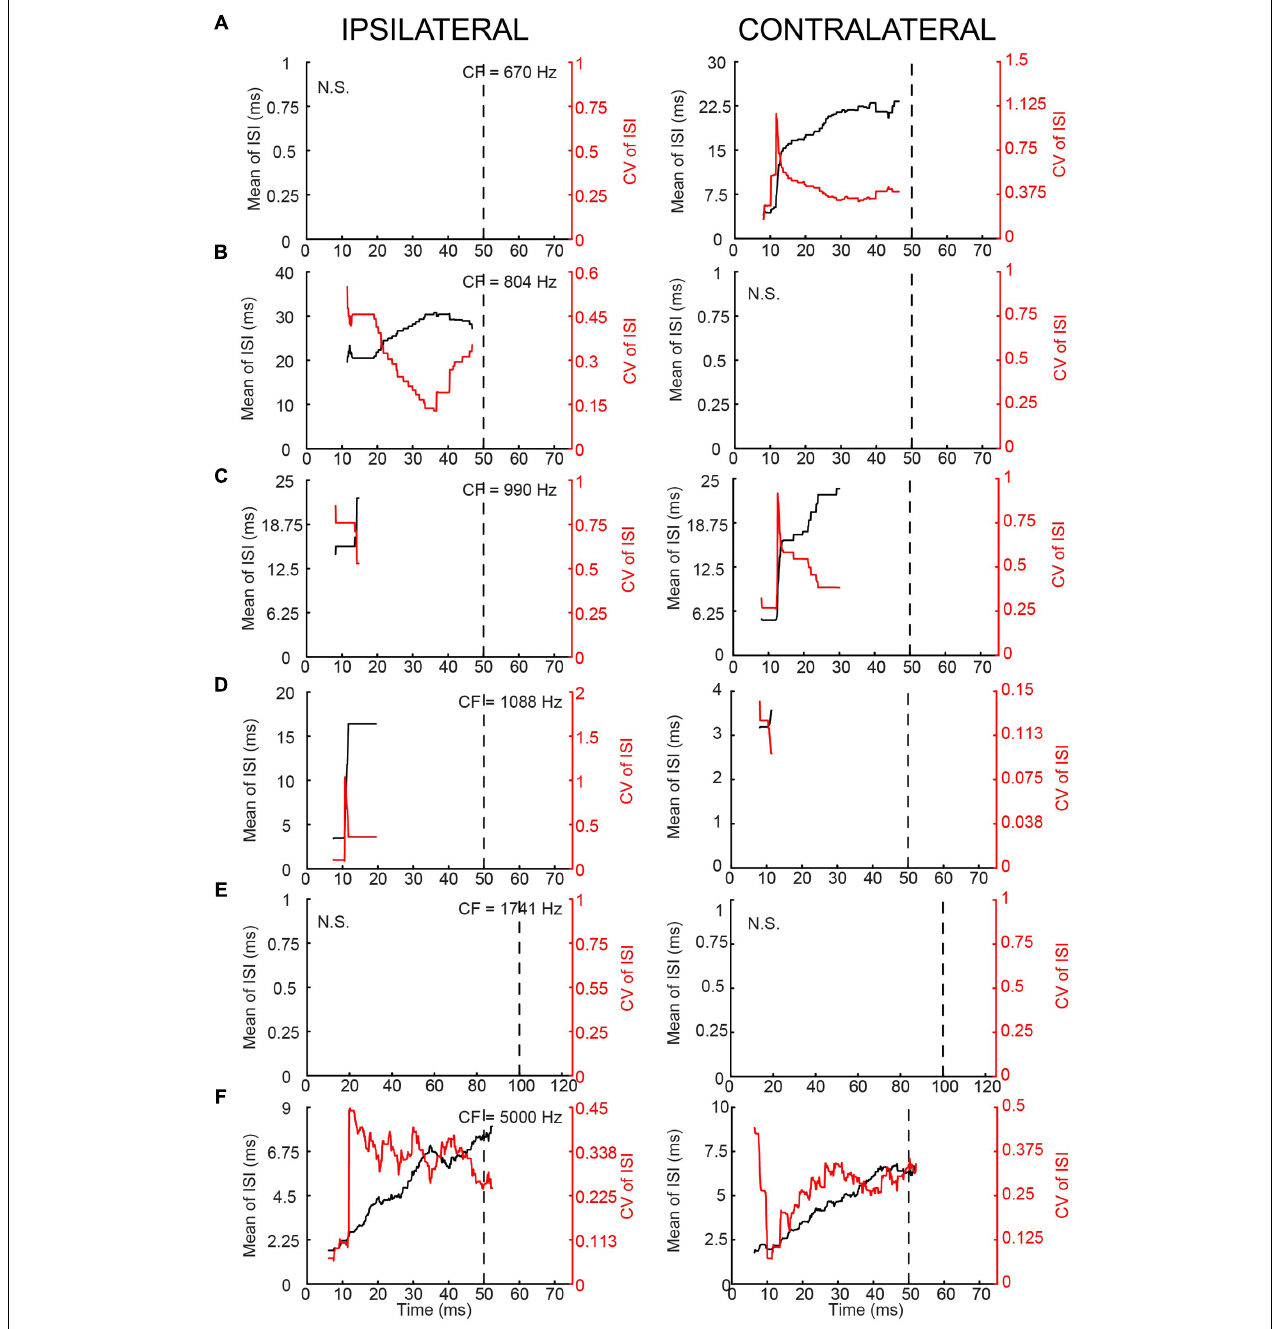
FIGURE 10 | Regularity analysis of mLNTB responses to short tones at CF. (A–F) Mean (black line) and CV (red line) of ISIs of responses to monaural tones at CF, for the corresponding neurons in Figure 9 . N.S., no